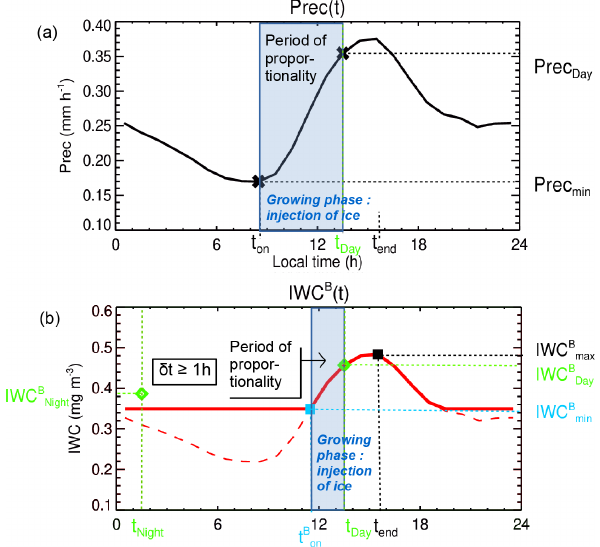
Figure 10. Methodology to estimate the diurnal cycle of ice water content (IWC) over land: (a) diurnal cycle of precipitation, with × representing the minimum of precipitation (Prec min ) with its associ- ated time ( t on ) and Prec during the day (Prec day ) at t day = 13:30LT. (b) The diurnal cycle of IWC B (t) is shown by the red solid line, es- timated from the diurnal cycle of Prec and from the two MLS mea- surements of ice (green diamonds, IWC B x ), with the timing of the onset of the ice injection at t B on = t on + δt B . The black square repre- sents the IWC maximum (IWC B max ) and the blue square the IWC B when δt B > 1h. Note that when t on ≈ t B on , the diurnal cycle of IWC is represented by the red dashed